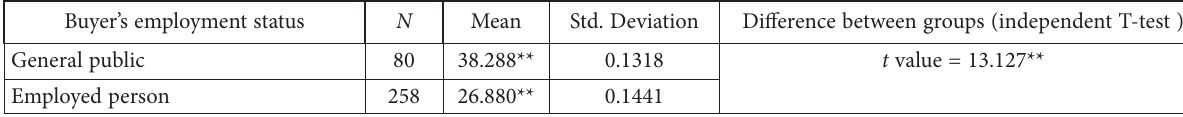
Table 10. Association between the Buyer’s employment status and the incidence under invoicing (source: author’s calculation) Buyer’s employment status N Mean Std.